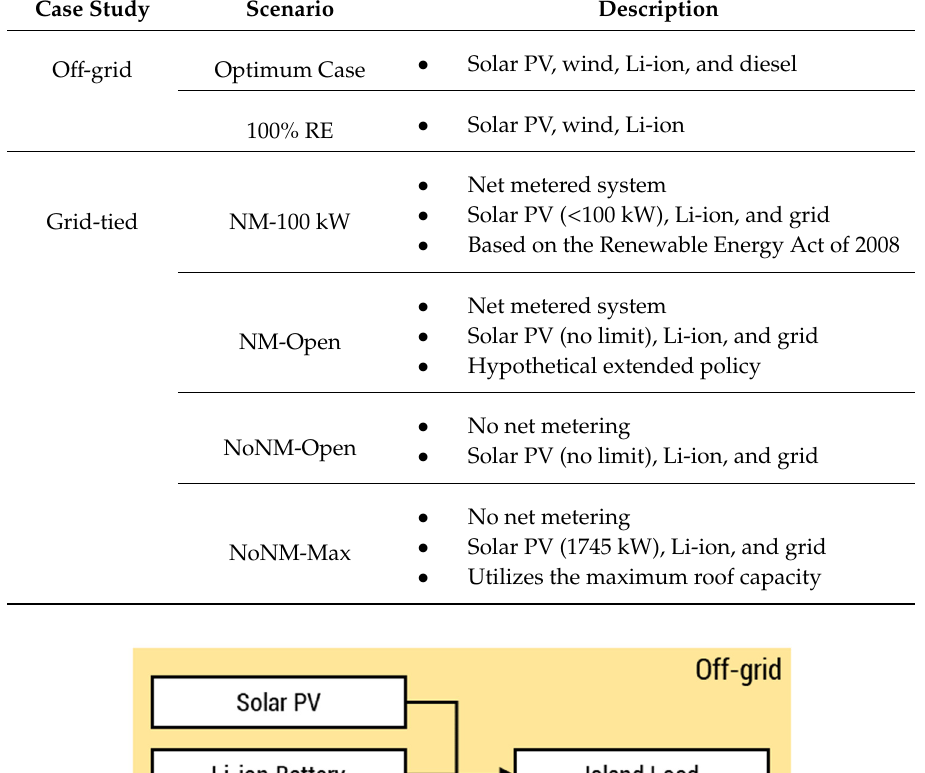
Table 1. Energy system LCOE calculation scenarios.